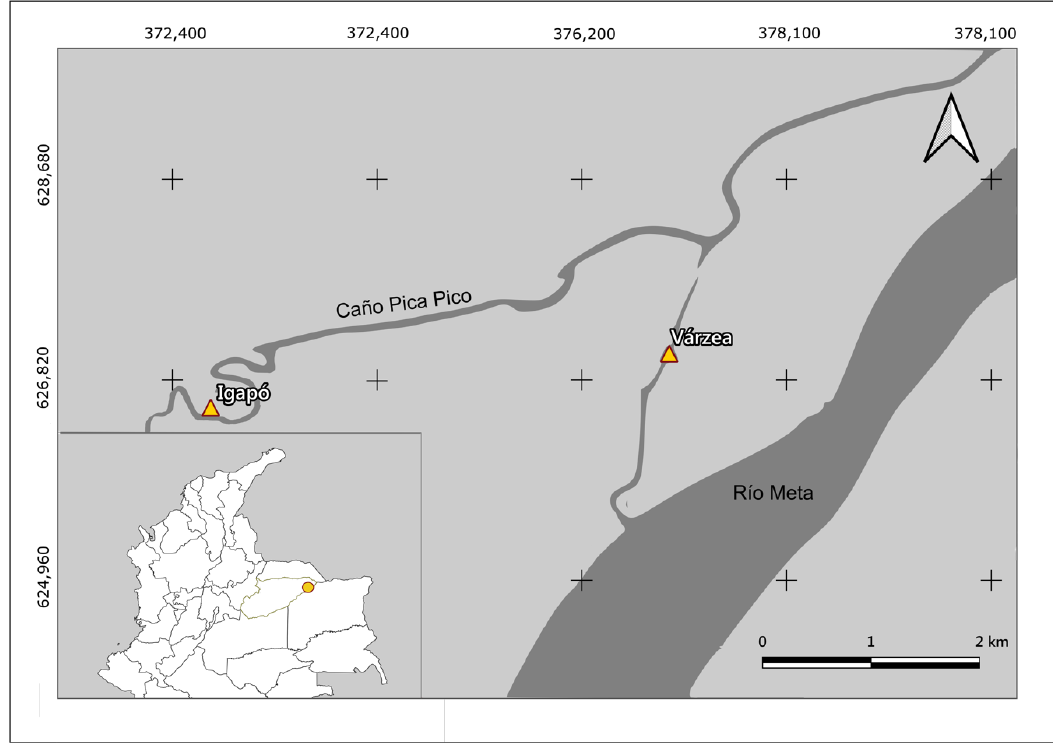
Figure 1. Location of sampled floodplain forest plots (1 ha) in Casanare, Colombia. Yellow triangles represent the location of each plot in igapó and várzea forests. The location of Casanare within Colombia is indicated in gray inset and the yellow circle denotes the study area.